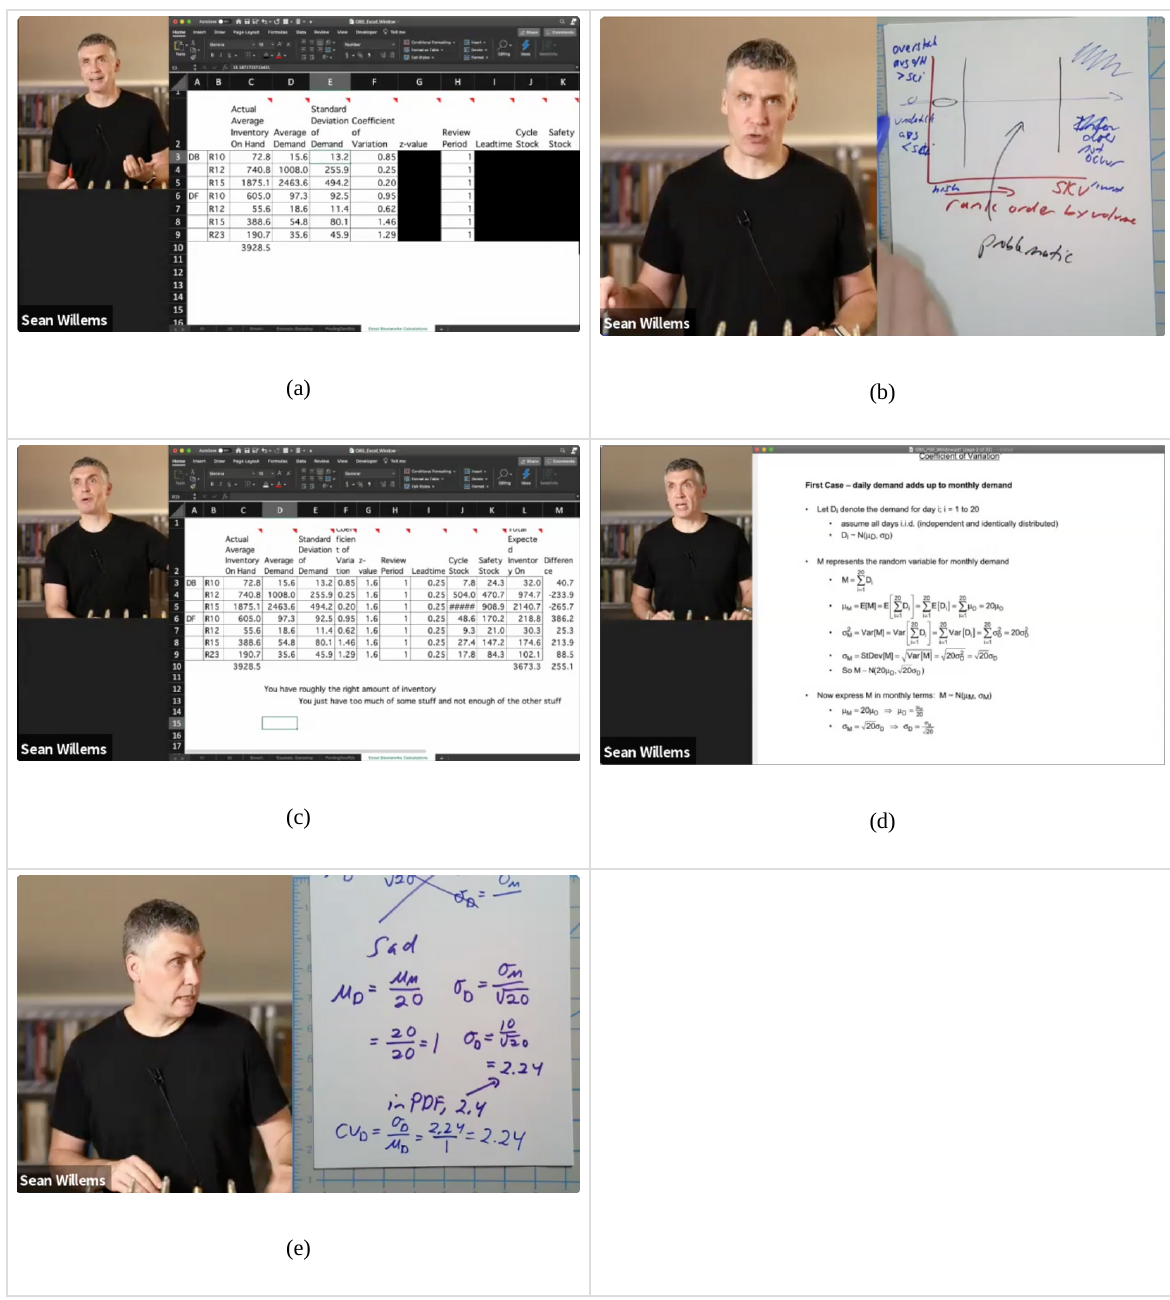
Figure 5. Example of Sean Willems’s changing views. (a) Excel view with model inputs hidden; (b) split screen with document camera to define timing of events for model; (c) Excel view with model inputs revealed; (d) PDF that demonstrates mathematical theory behind model; and (e) split screen with document camera to write out modeling